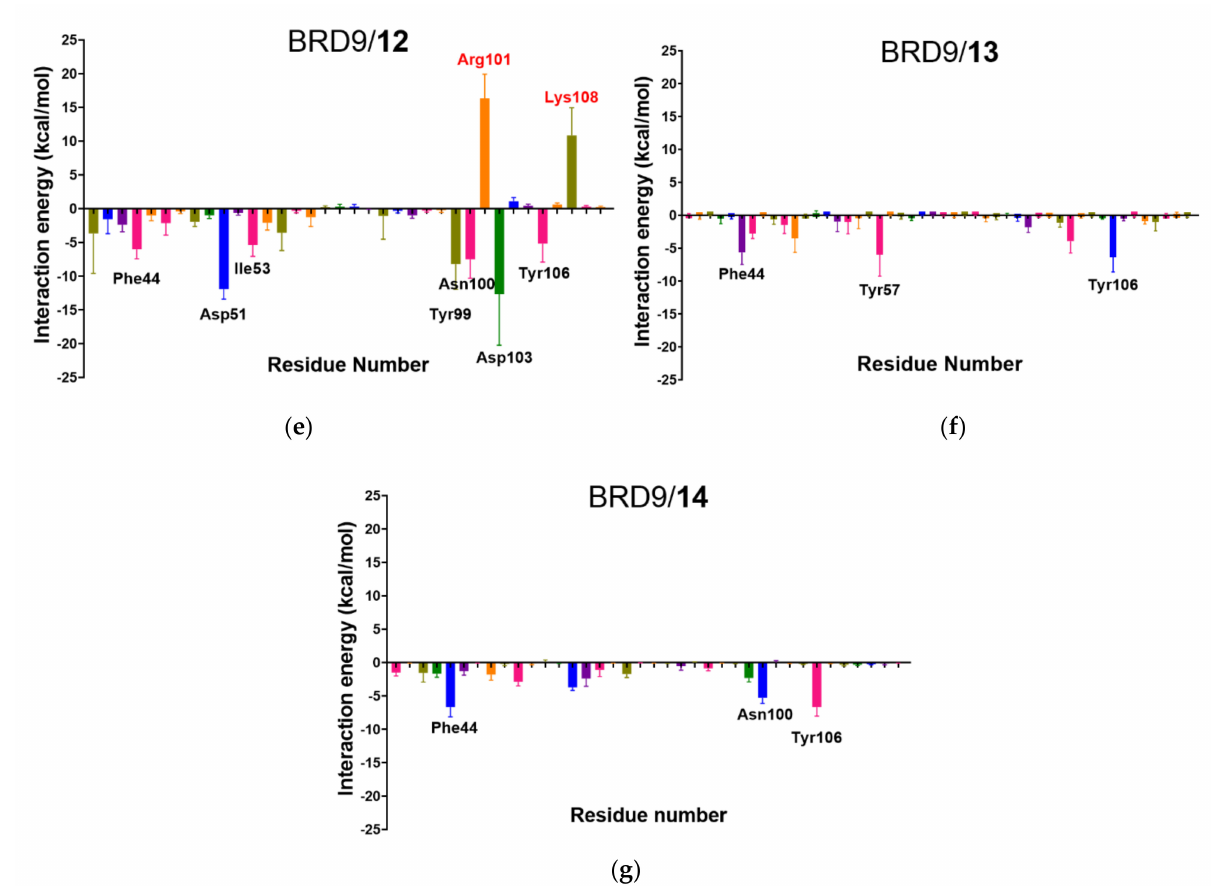
Figure 13. ( a – g ) Per-residue interaction of the six complexes. Residues with energetic values below − 5.0 kcal/mol are labeled in black and residues with values above +5.0 kcal/mol are labeled in red, specifically for( a ) BRD9/ 9 , ( b ) BRD9/ 10a , ( c ) BRD9/ 10b , ( d ) BRD9/ 11 , ( e ) BRD9/ 12 , ( f ) BRD9/ 13 , ( g ) BRD9/ 14